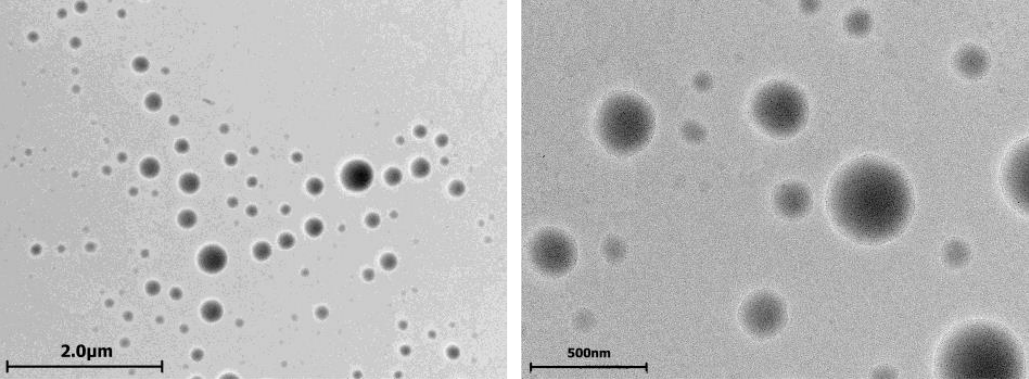
empty lumen, which means that cerasomes formed with this method are either multilamel- lar or more closely related to solid lipid nanoparticles.